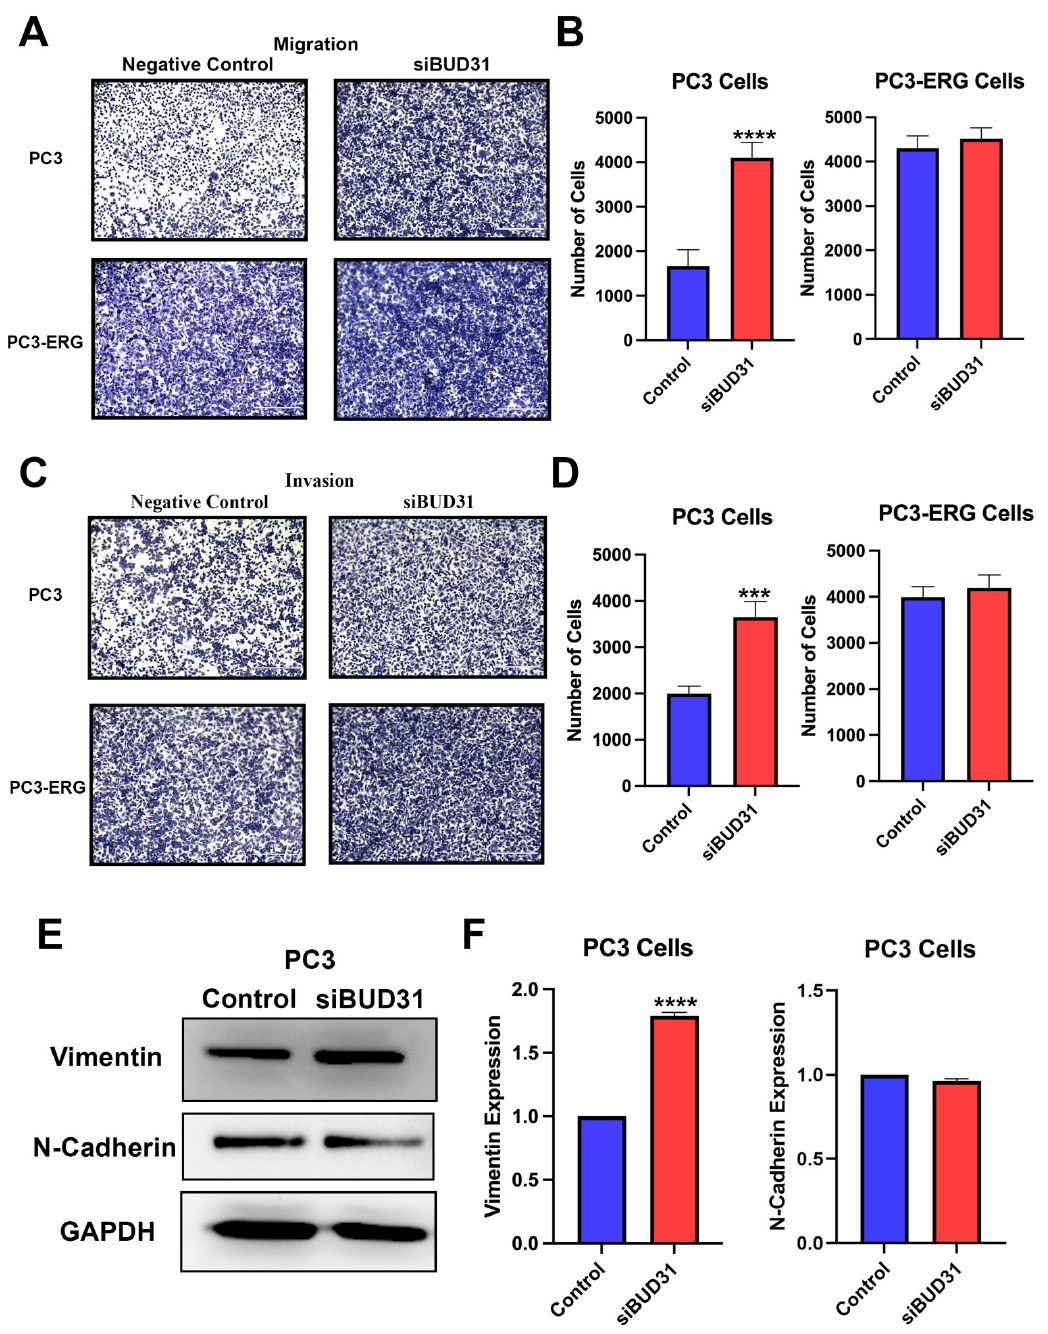
Figure 5. Inhibition of BUD31 enhances the ability of prostate cancer cells to migrate and invade.